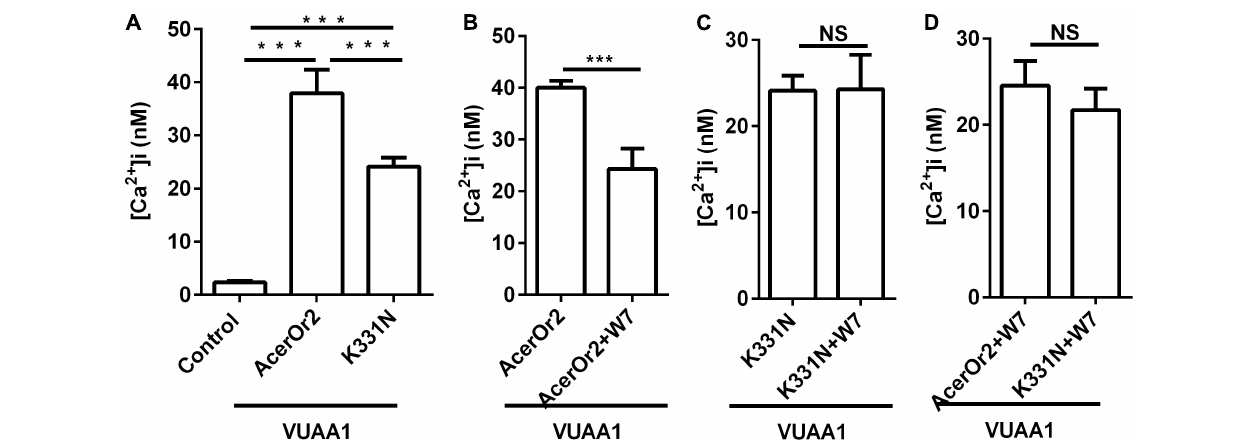
FIGURE 3 | VUAA1-stimulated Ca 2 + influx activity of AcerOr2 and its CaM-binding mutant (K331N) constructs expressed in Sf9 cells treated with the agonist VUAA1 in the absence/presence of 10 µ M CaM inhibitor W7. (A) Average recording of [Ca 2 + ] i in Sf9 cells expressing no AcerOr2 (empty vector), AcerOr2, or the CaM mutant stimulated with 100 µ M VUAA1 in the absence of 10 µ M W7. (B) Average recording of [Ca 2 + ]i in Sf9 cells expressing AcerOr2 stimulated with 100 µ M VUAA1 in the absence or presence of 10 µ M W7. (C) Average recording of [Ca 2 + ] i in Sf9 cells expressing the AcerOr2 CaM mutant (K331N) stimulated with 100 µ M VUAA1 in the absence or presence of 10 µ M W7. (D) Average recording of [Ca 2 + ] i in Sf9 cells expressing the AcerOr2 and its CaM mutant (K331N) stimulated with 100 µ M VUAA1 in the presence of 10 µ M W7. The data are expressed as the mean ± SEM ( n = 15), and data were analyzed using one-way ANOVA (A) and t -test (B–D) ; ∗∗∗ P < 0.001. NS, not